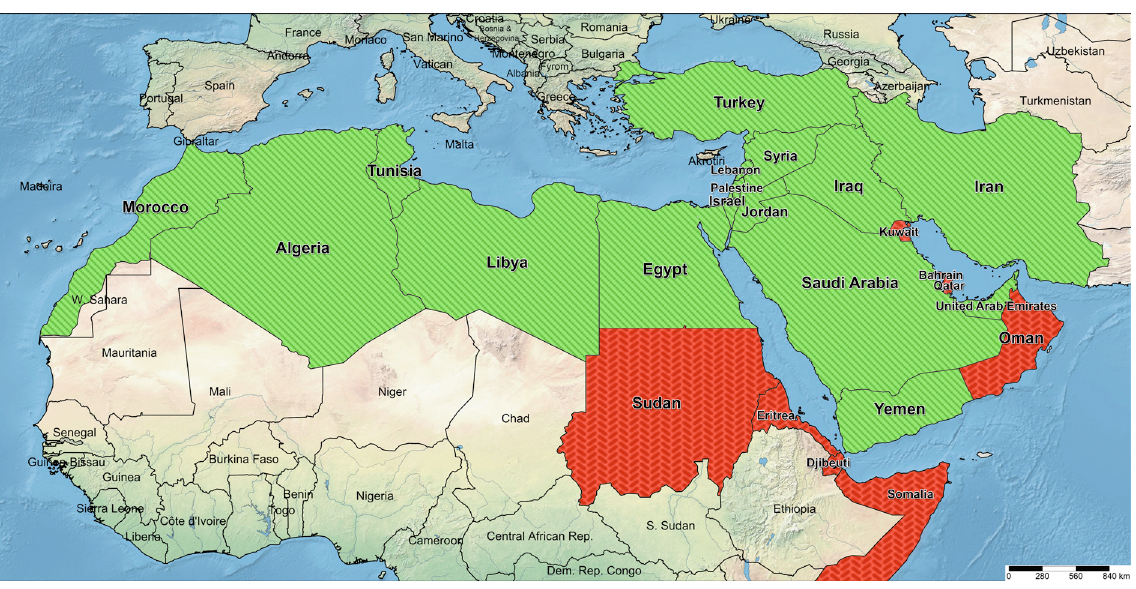
Fig. 613 . Map of the Middle East and North Africa. A country is highlighted with green color indicates that there are available data on aphidiine parasitoids. A country highlighted with red color, indicates that there are no available data on aphidiine